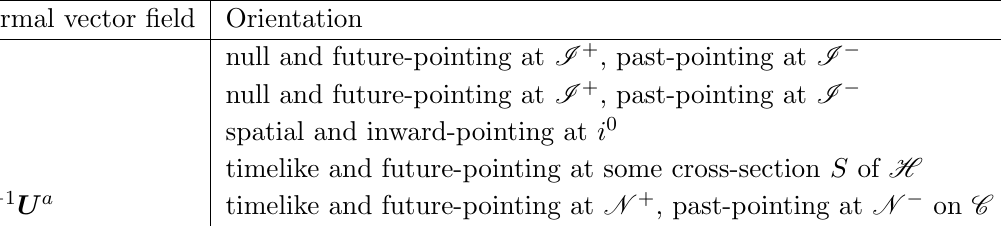
Table 1 . Conventions for orientation of